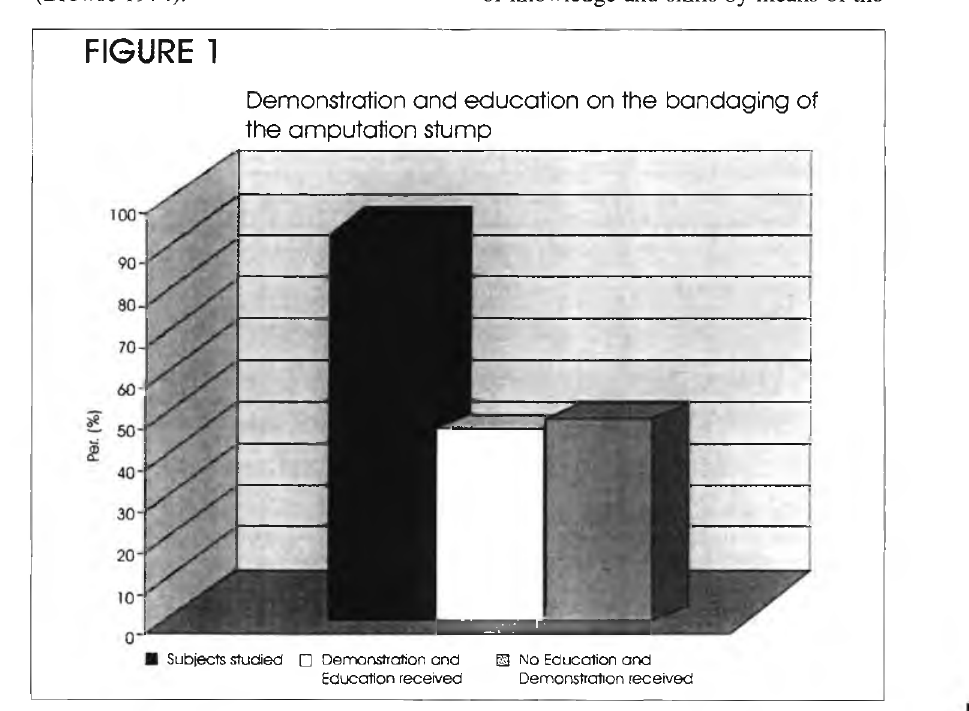
Fig 1: Demonstration and education on the bandaging of the amputation stump.